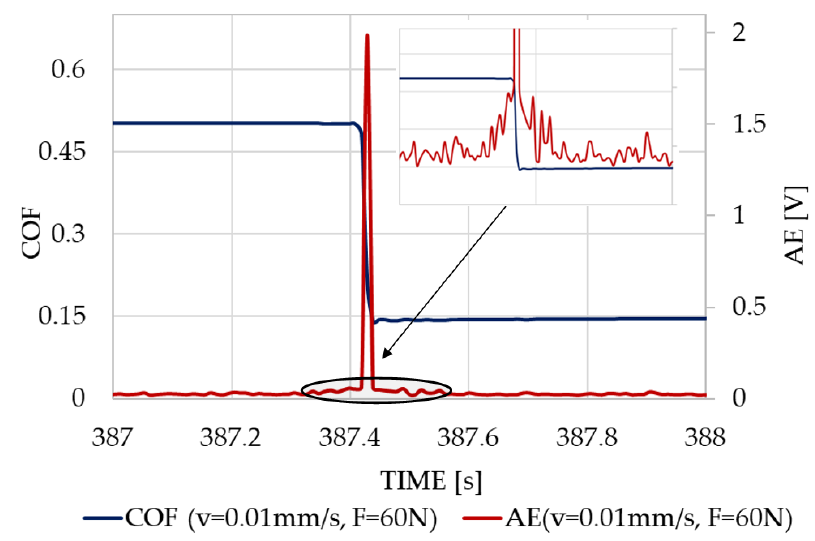
Figure 6. The variation in the friction coefficient and acoustic emission (peak extracted).